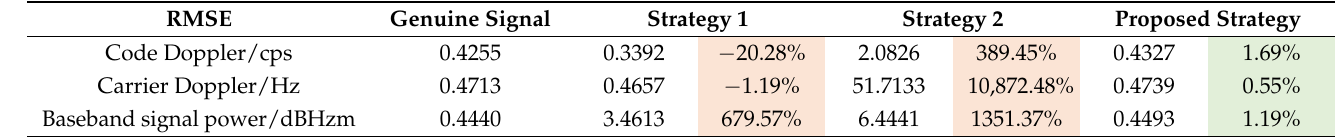
Table 7. Comparison of RMSE for different strategies and the genuine signal (C/N 0 = 60 dBHz, D = 1).